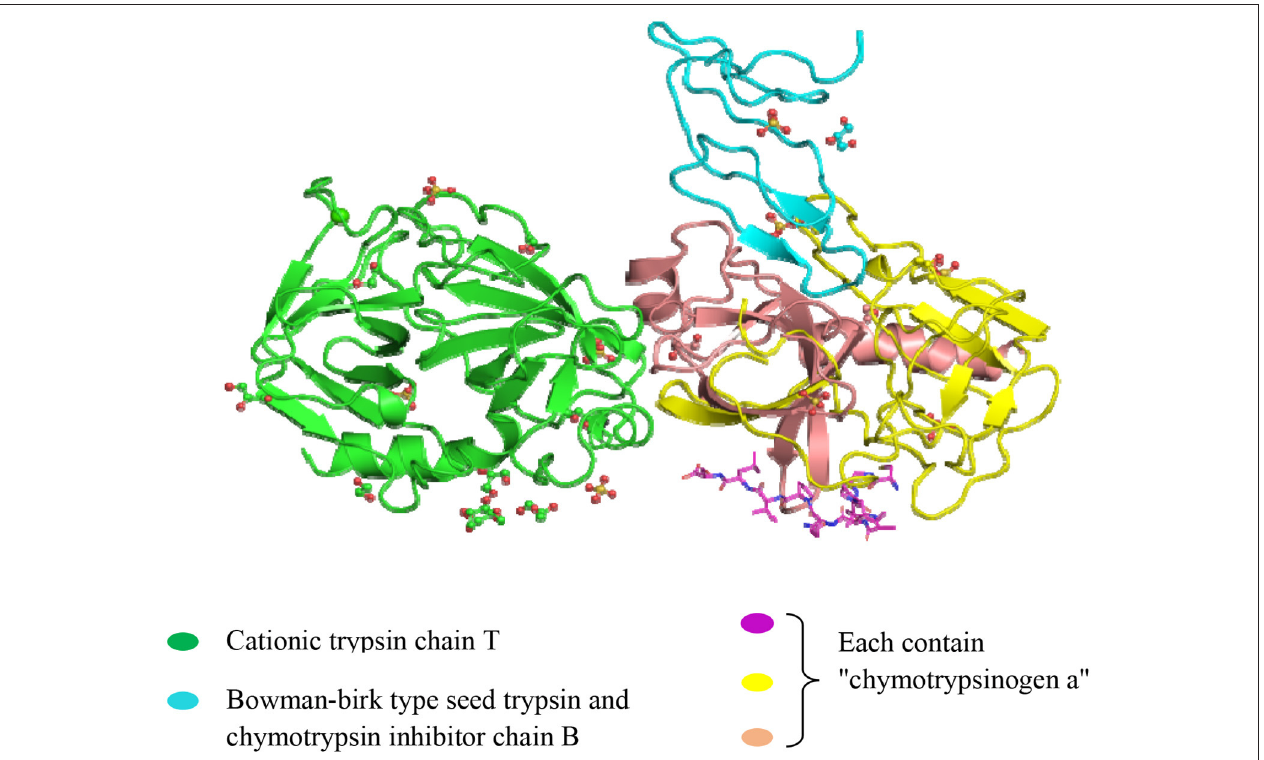
FIGURE 4 | Crystal structure of the Bowman-Birk serine protease inhibitor BTCI in complex with a copy of cationic trypsin and three copies of chymotrypsinogen A. (http://www.ebi.ac.uk/pdbe-srv/view/entry/3ru4/summary.html).